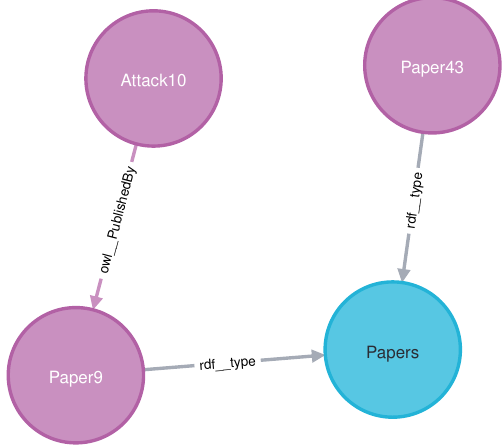
Figure 13. The result of the shortest path